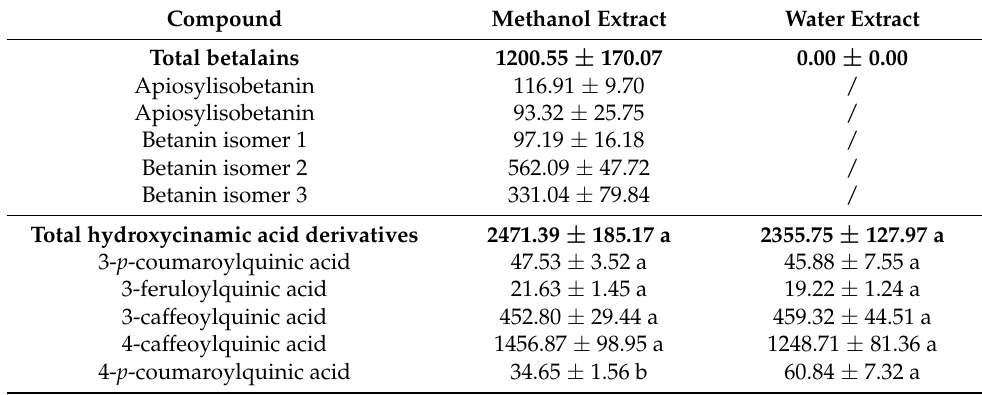
Table 3. Contents of individual analyzed secondary metabolites with standard error ( µ g/g DW) in American pokeweed with two extraction